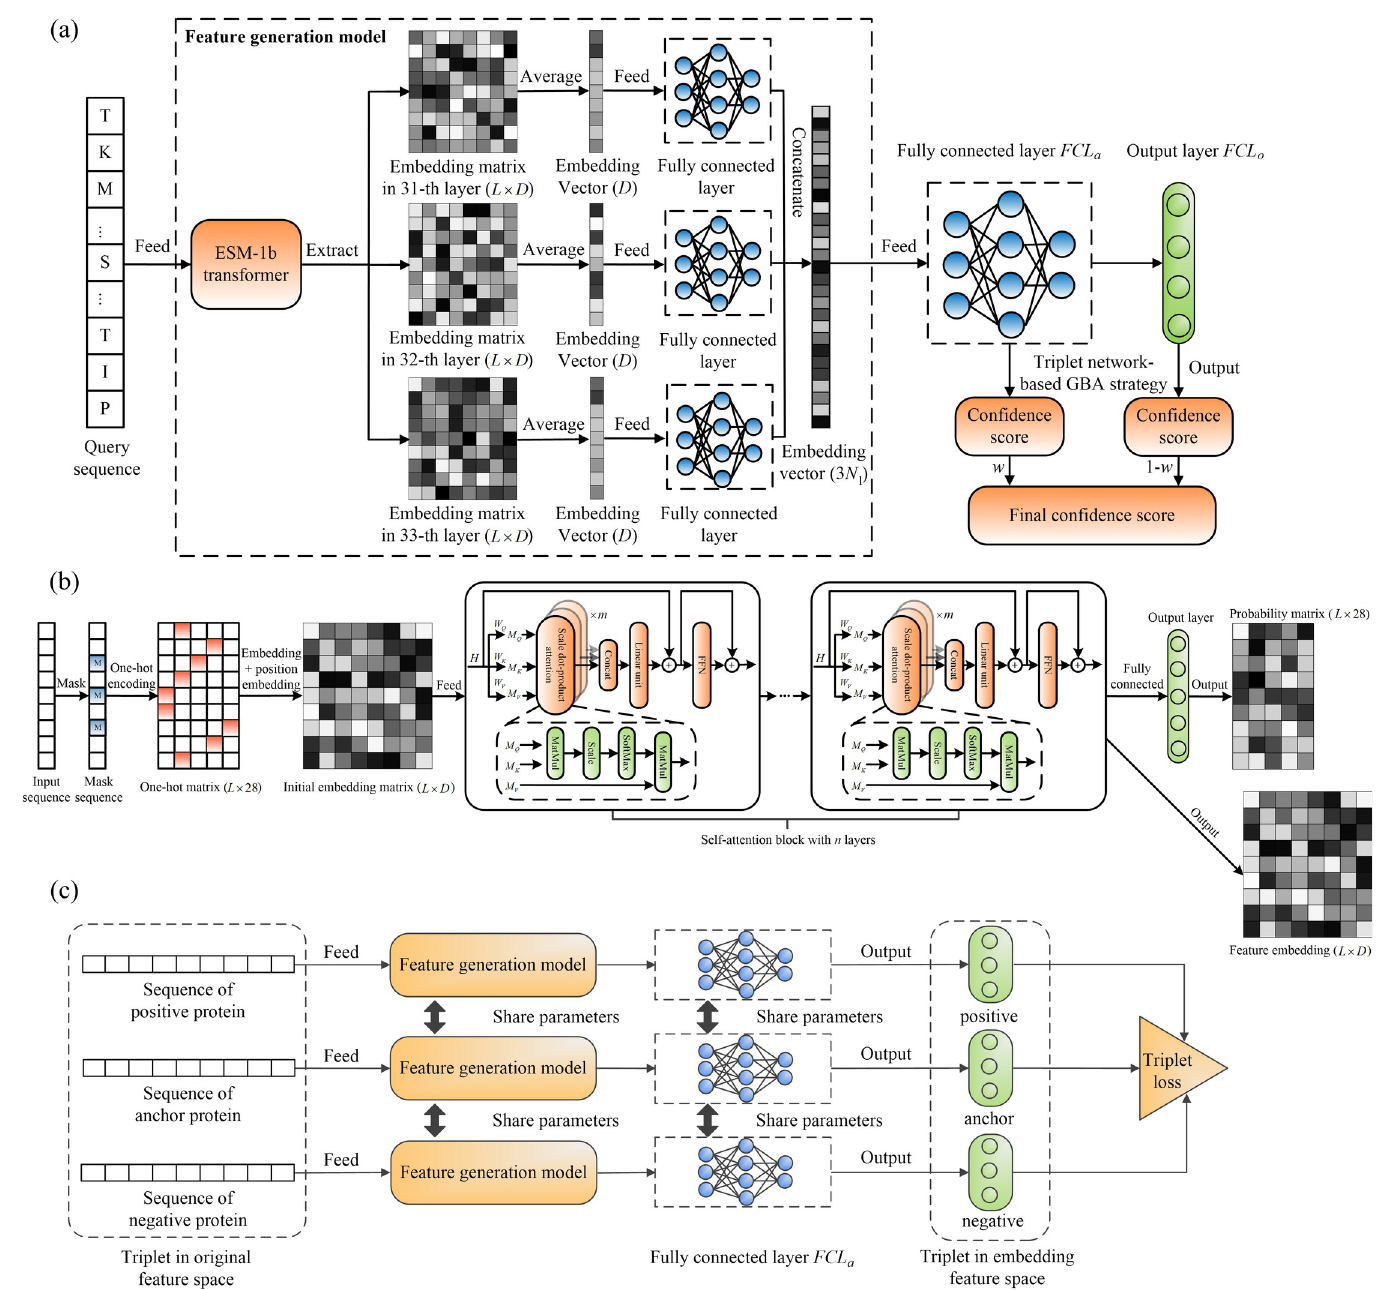
Fig 1. The procedures of ATGO for protein function prediction. (a) The workflow of ATGO. Starting from the input sequence, the ESM-1b transformer is utilized to generate the feature embeddings from the last three layers, which are fused by a fully connected neural network. The fused feature embedding is then fed into a triplet network to create confidence scores of GO models. (b) The structure of ESM-1b transformer. For an input sequence, the masking, one-hot encoding, and position embedding are orderly executed to generate the coding matrix, which is then fed into a self-attention block with n layers. Each layer can output a feature embedding matrix from an individual evolutionary view through integrating m attention heads with a feed-forward network, where the scale dot-product attention is performed in each head. (c) The design of a triplet network for assessing feature similarity. The input is a triplet variable ( anc , pos , neg ), where anc is an anchor (baseline) protein, and pos (or neg ) is a positive (or negative) protein with the same (or different) function of anc . Each sequence is fed into the designed feature generation model to extract a feature embedding vector, as the input of fully connected layer to output a new embedding vector. Then, the feature dissimilarity between two proteins is measured by Euclidean distance of embedding vectors. Finally, a triplet loss is designed to enhance the relationship between functional similarity and feature similarity in embedding space.